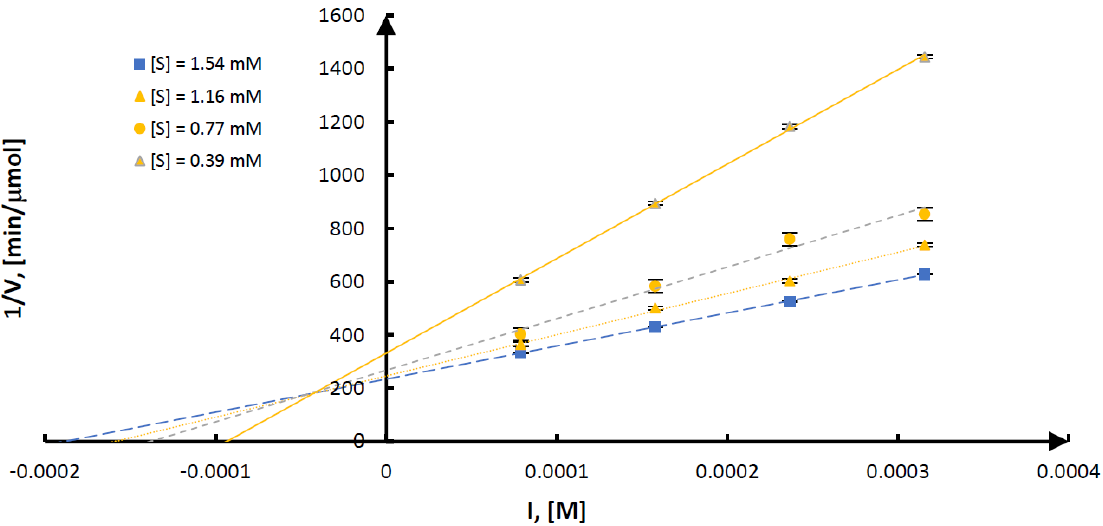
Figure 4. The designation of type inhibition and the inhibition constant K I by Dixon method for compound 1 in the presence of HvLAP.